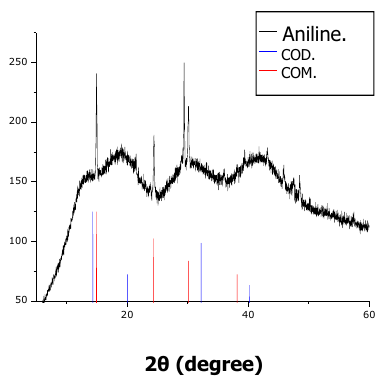
Figure 6. XRD patterns of the CaOx crystals grown on sulphonated PS films diazotated with aniline. The black line corresponds to the diazotated sulphonated polystyrene films sample pattern, and the red line to a standard pattern.